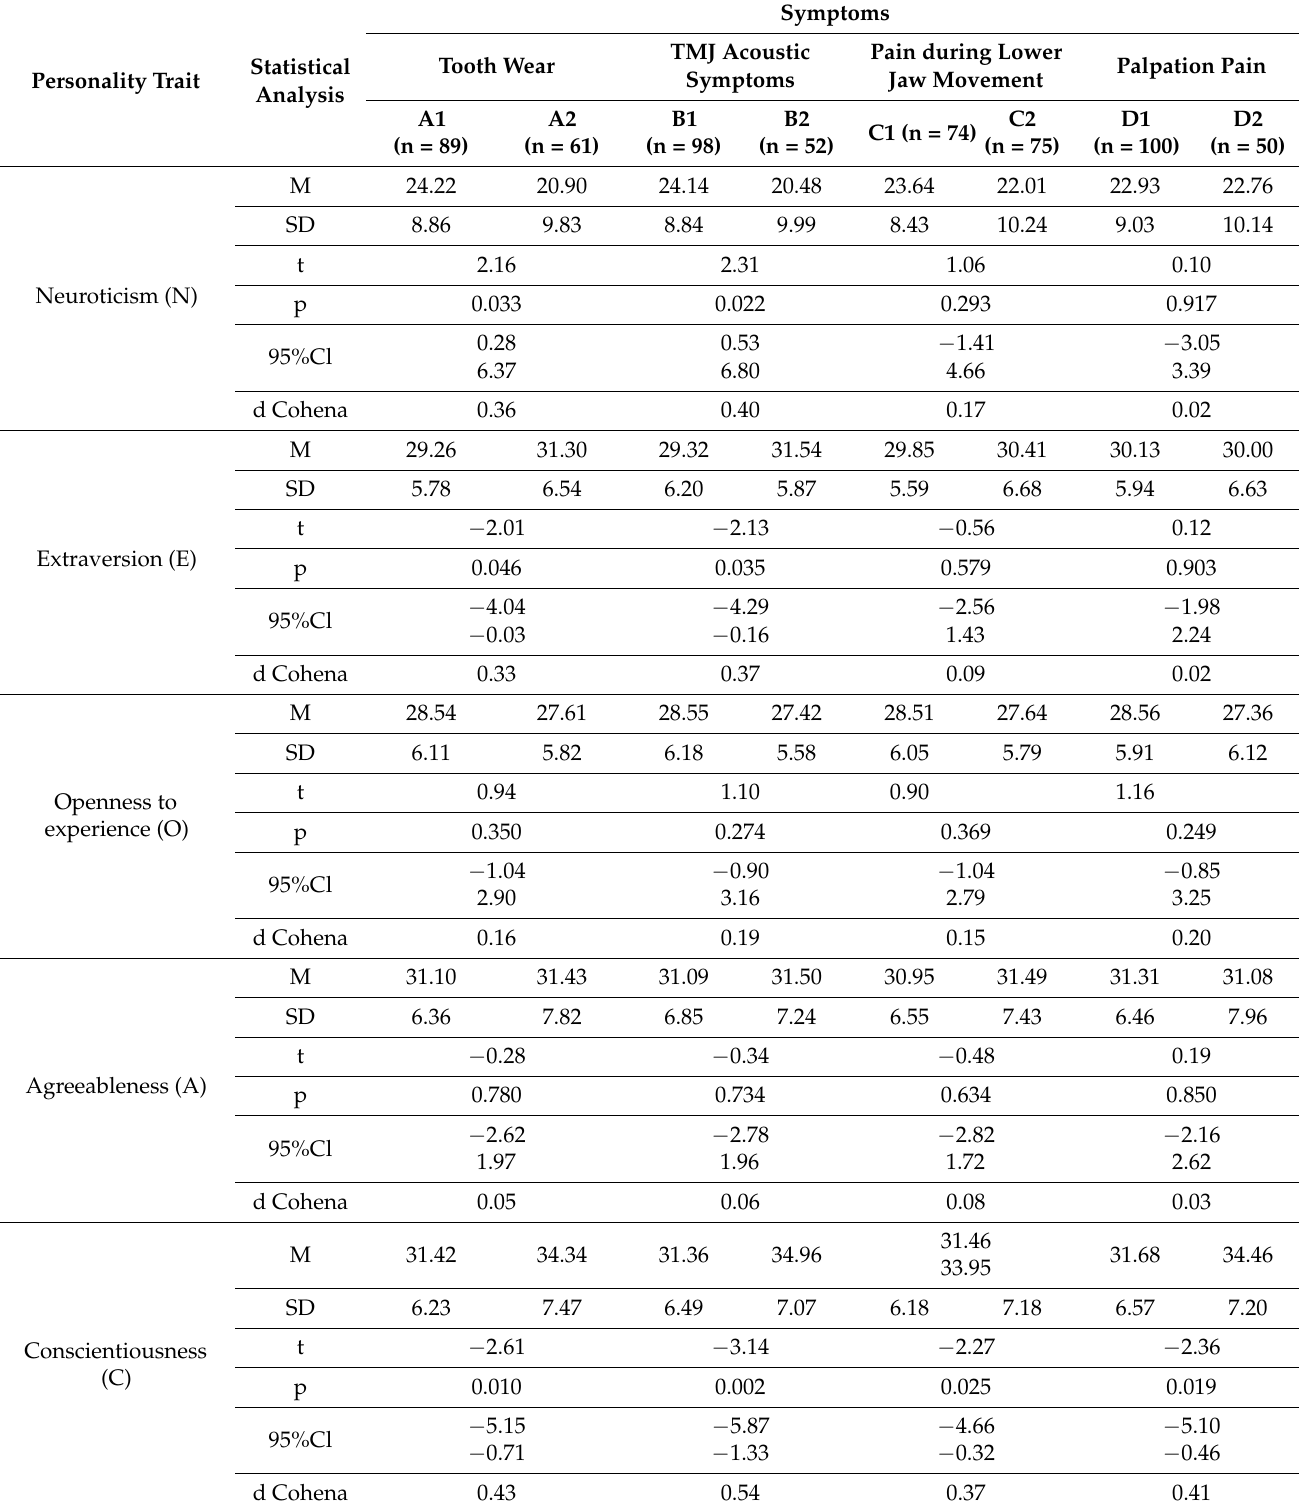
Table 3. Comparison of intensity of personality traits among the analyzed participants with SSDs (stomatognathic system